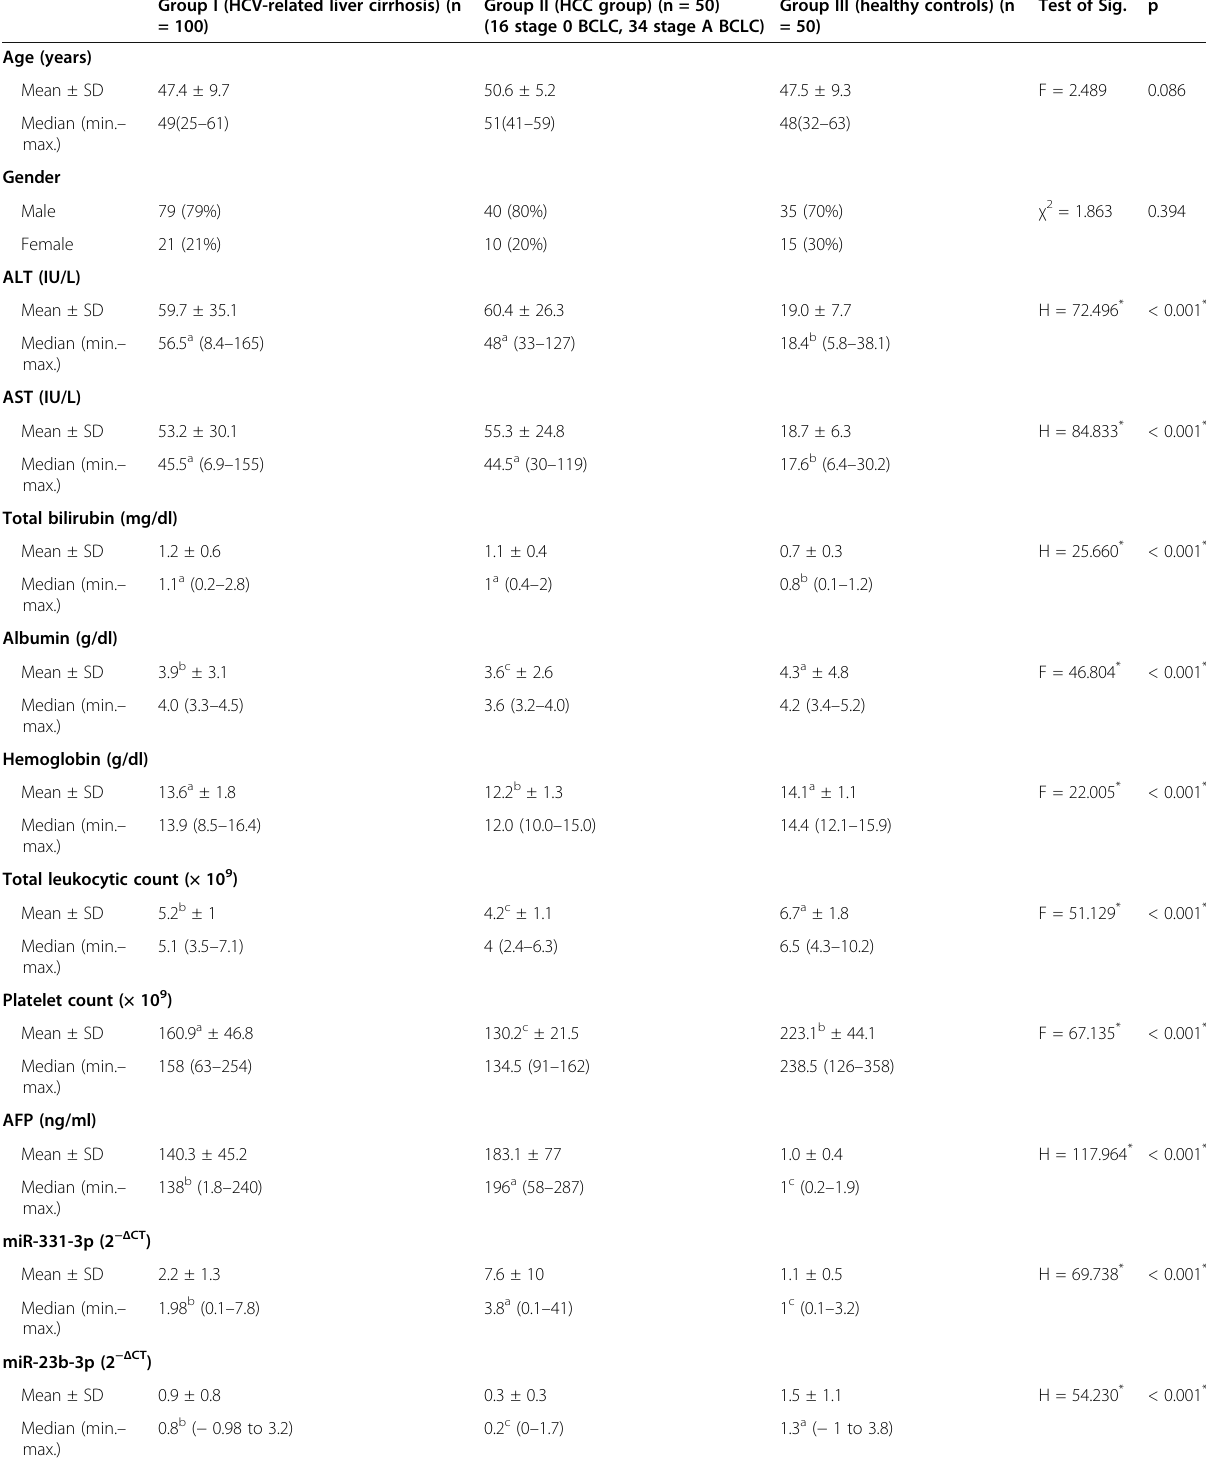
Table 1 Comparison between the three studied groups according to the demographic data, laboratory investigations, and serum concentrations of miR-331-3p and